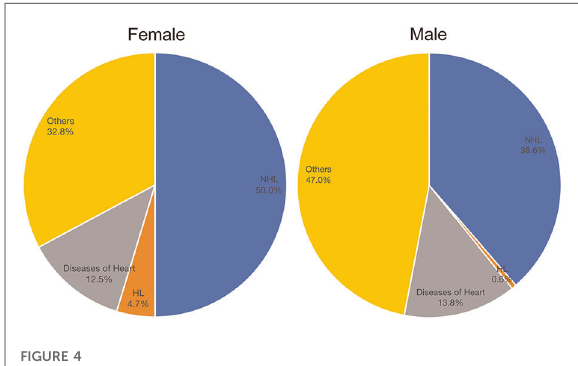
FIGURE 4 Kaplan – Meier survival curves and log-rank tests for male patients with primary breast lymphoma grouped by age and